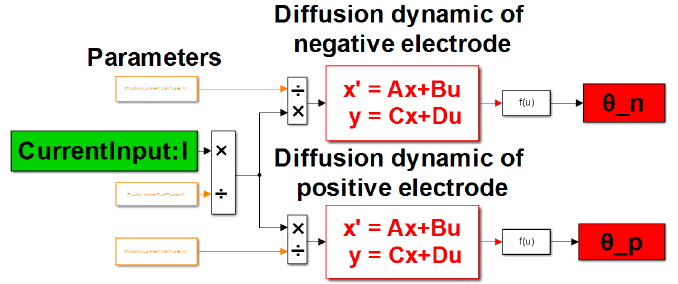
Figure 2. Solid phase lithium-ion diffusion kinetic model.